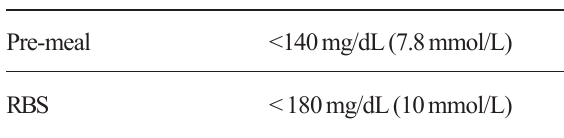
Table 5. Blood glucose targets